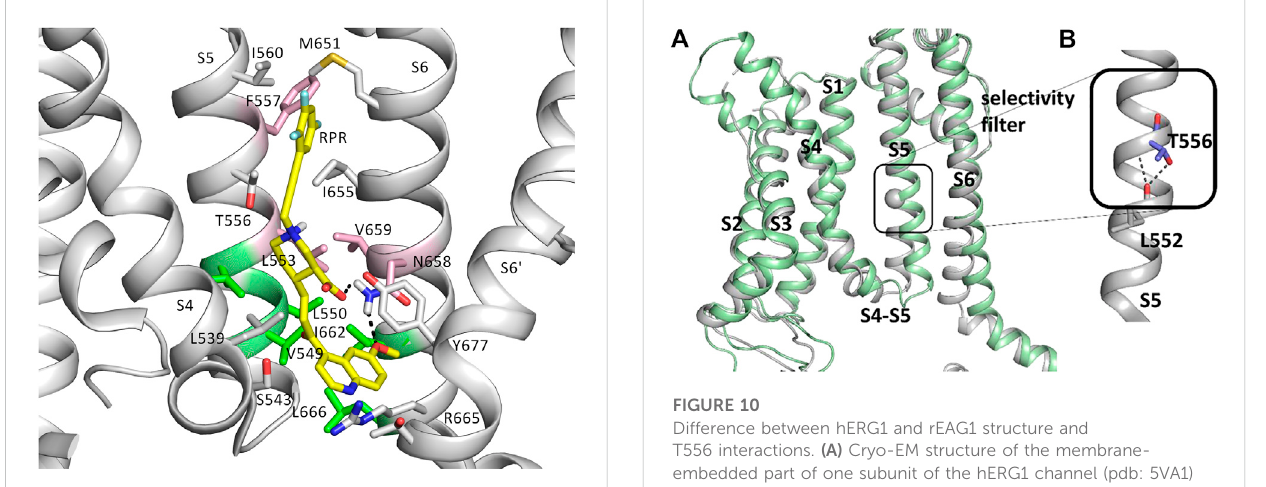
FIGURE 9 The putative binding site of RPR. Binding residues and RPR are presented as sticks. RPR is shown in yellow. Residues represented in pink are known from experiments to prevent slowing of deactivation and reduced the shift of V 0.5 of inactivation by RPR. Those in green weakened the effect of deactivation, but did not change the effect of RPR an inactivation. Gray residues are within 6 Å of RPR.